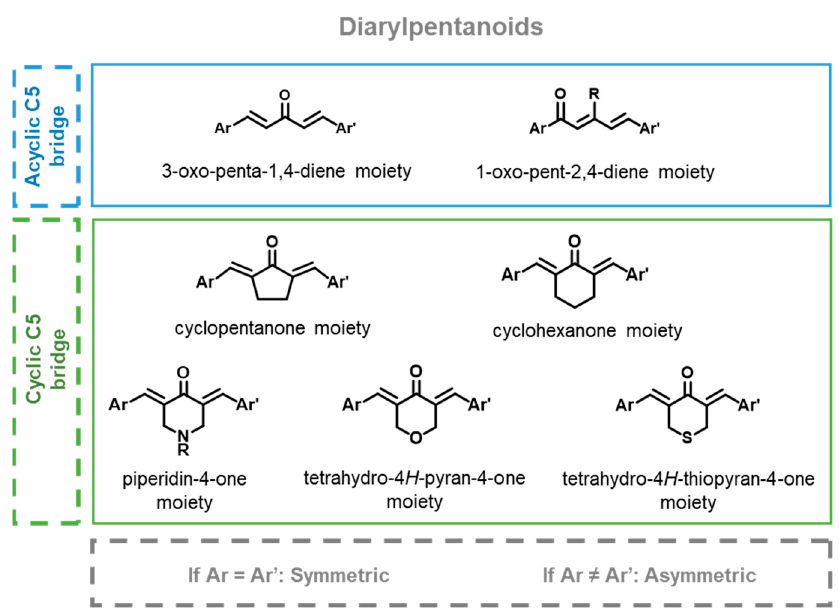
Figure 1. General structure of diarylpentanoids.